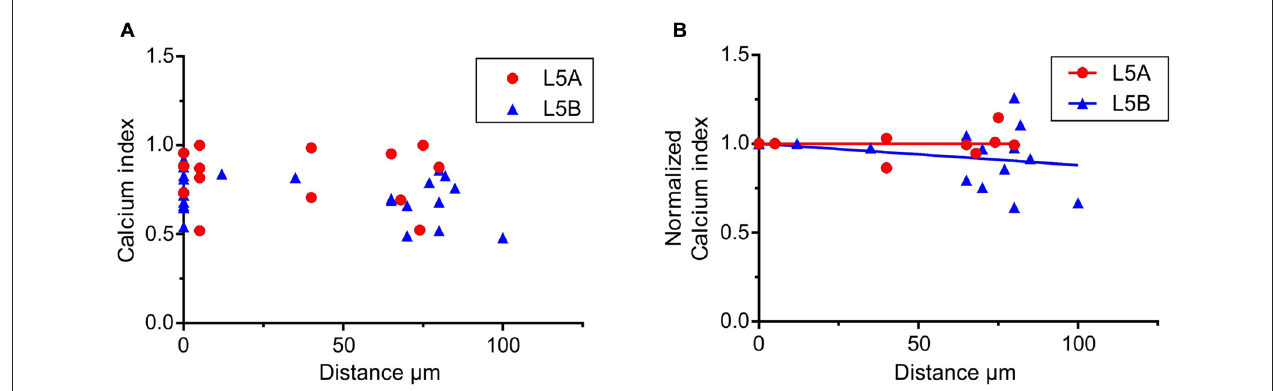
FIGURE 4 | Calcium responses elicited by simulated whisker-evoked AP patterns. The aim in this analysis was to quantify the relative changes in calcium caused by whisker stimulation. The larger the post-whisker stimulation evoked calcium influx is in comparison to the calcium influx before whisker stimulation, the closer the calcium index [1 – (Ca-pre-whisk/Ca-post-whisk)] is to one. (A) In both L5A-st and L5B-tt cells the calcium response increases due to whisker deflection (the calcium index is > 0). (B) To quantify the changes along the length of the basal dendrite the bAP evoked calcium response was normalized to the response close to the soma (5–10 µ m) for each individual dendrite branch. In L5A-st cells the calcium index remains close to 1 (linear regression P = 0.7804) through the length of the basal dendrite (measured up to 125 µ m), indicating that there is a substantial relative increase in calcium after whisker stimulation. In contrast in L5B-tt cells the calcium index decreases slightly with distance (linear regression, P = 0.0204) indicating that further out on the basal dendrite the relative increase in calcium influx caused by whisker stimulation